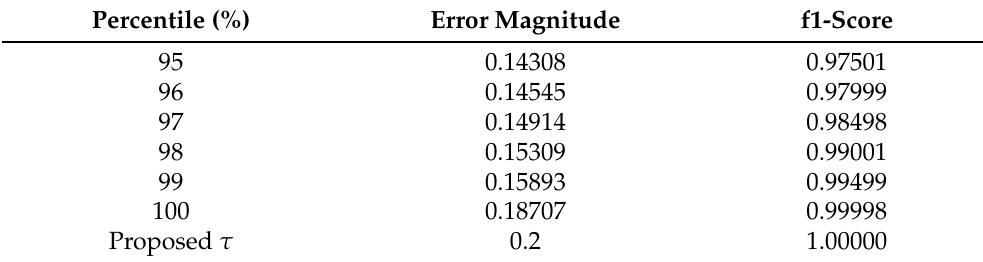
Table 8. f1-score at different threshold value for proposed model trained with minutely data.